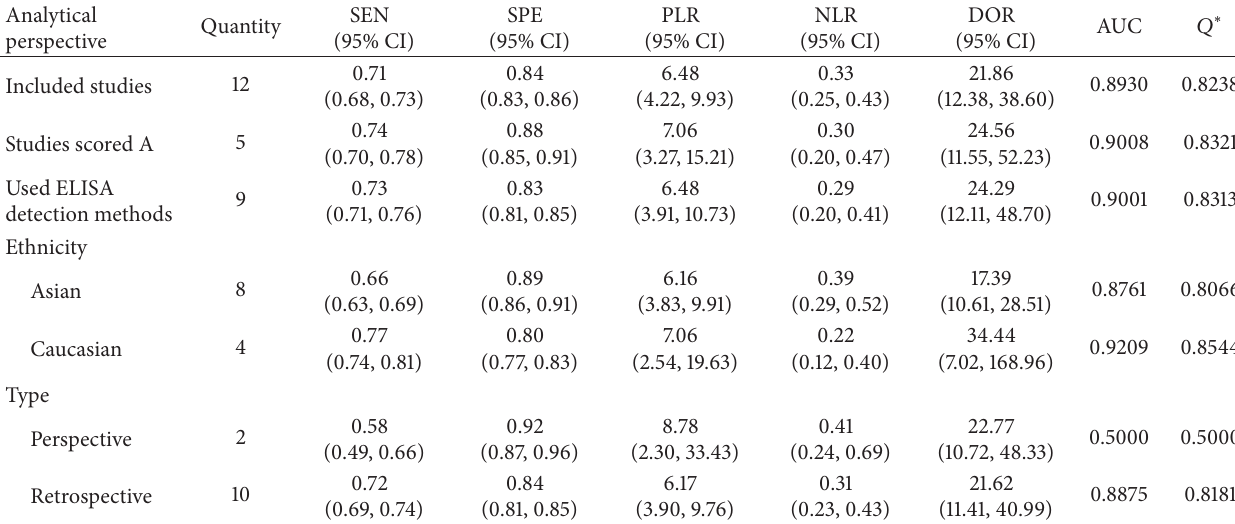
Table 4: Results of the sensitivity analysis using 3 criteria.